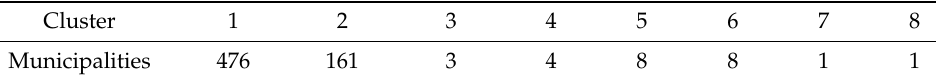
Table 3. Clusters of municipalities.